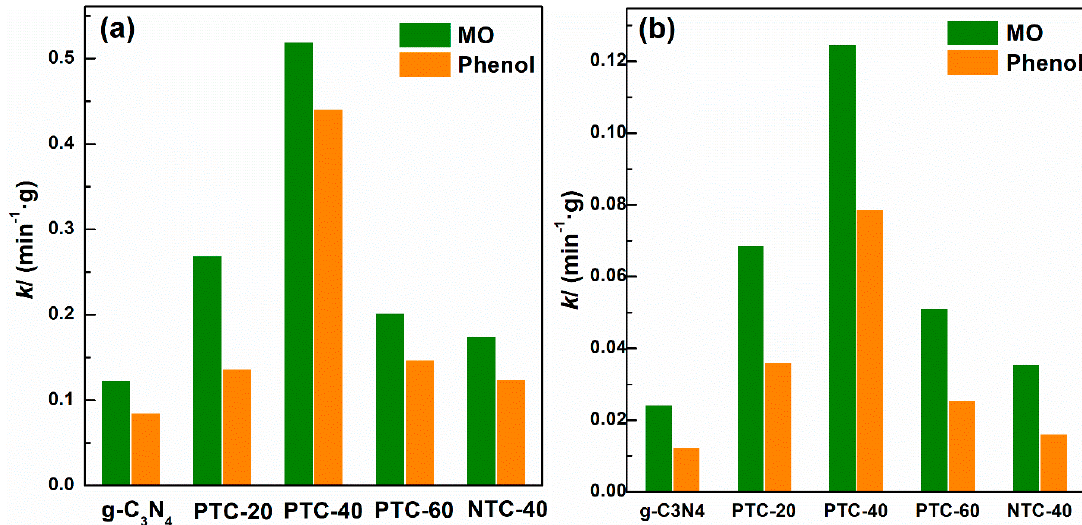
Figure 9. Pseudo-first-order reaction rate in degradation of methyl orange (MO) and phenol under: ( a ) full solar spectrum and ( b ) visible light ( λ > 400 nm).